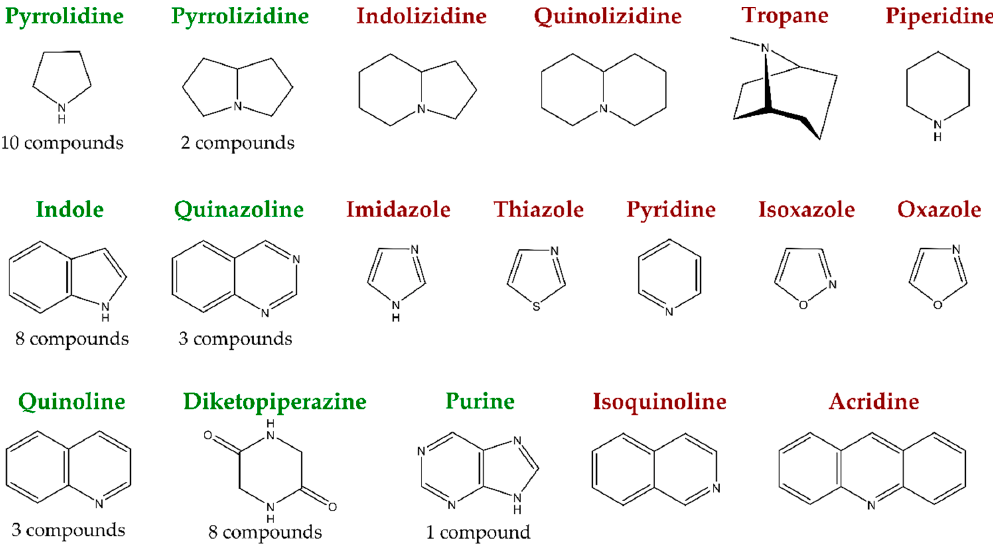
Figure 1. On the left, in green, structural alkaloid groups for which novel compounds with antimicrobial properties are reported since 2015, isolated from marine fungi, alongside with how many compounds in total were found. On the right side, in red, the remaining groups of true